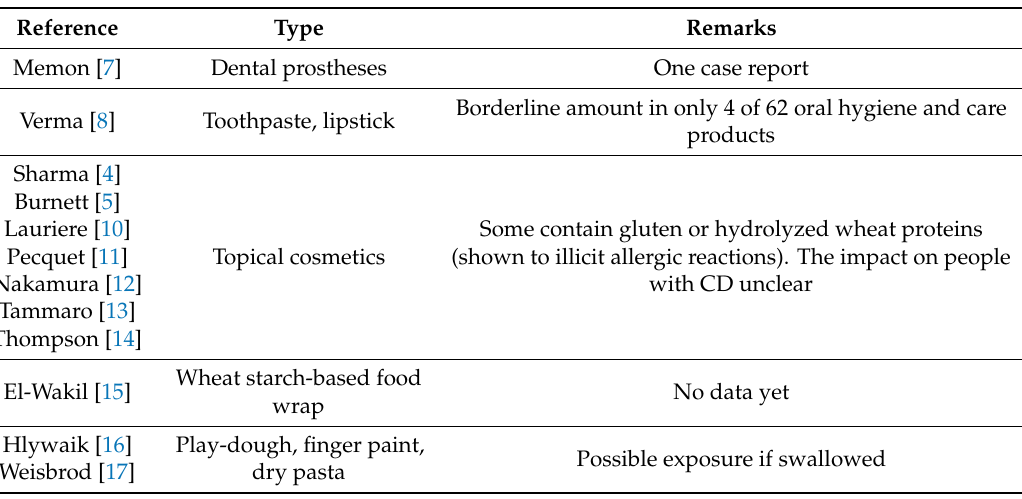
Table 1. Possible non-food gluten sources which may impact patients with coeliac disease